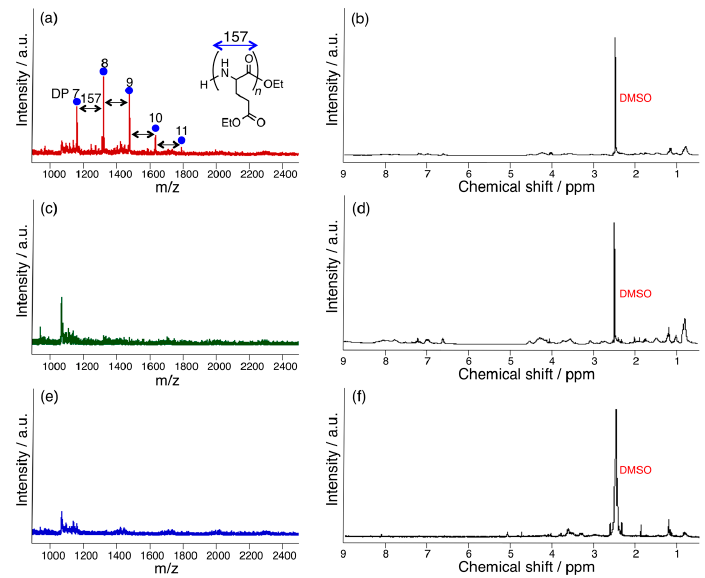
Figure 3. MALDI-TOF MS ( a , c , e ) and 1 H-NMR ( b , d , f ) spectra of bromelain ( a , b ), proteinase K ( c , d